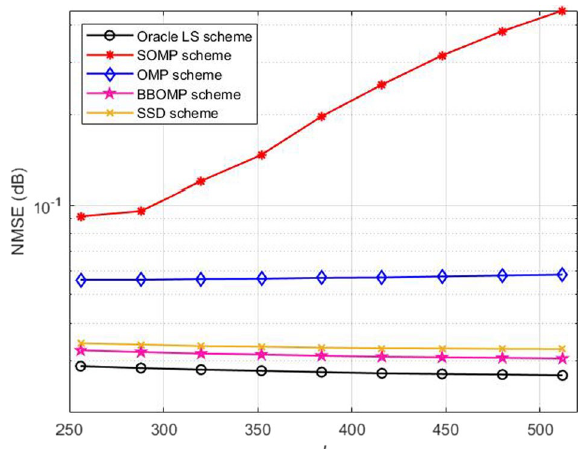
Fig. 9 The NMSE performance results of different schemes versus the number of antennas